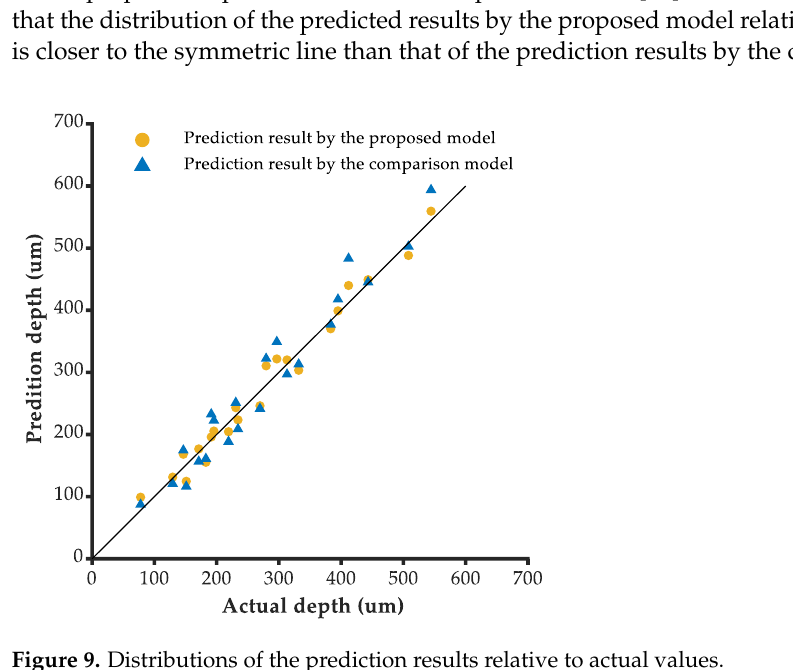
Figure 9. Distributions of the prediction results relative to actual values.